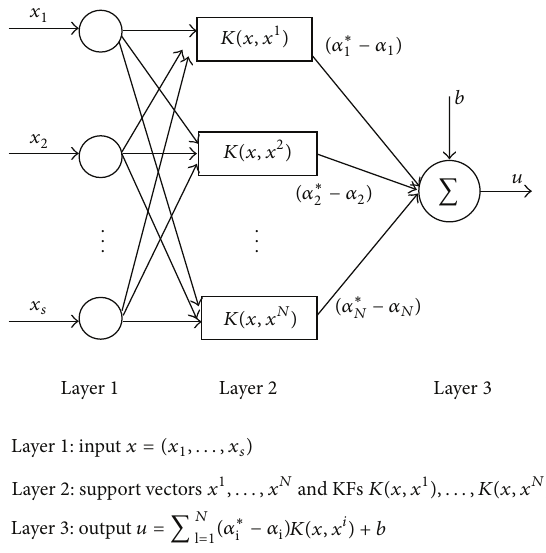
Figure 10: Three-layer network structure of an